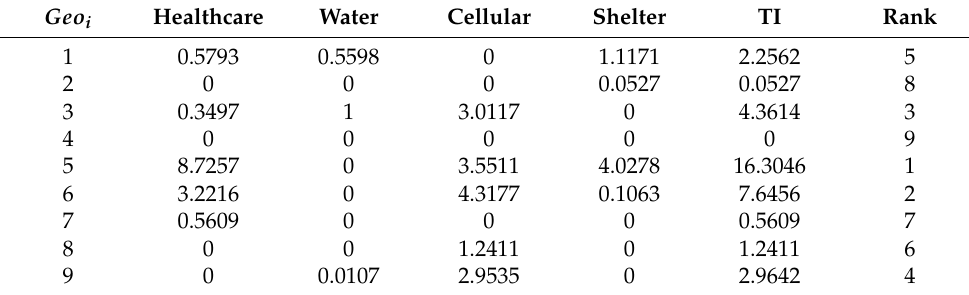
Table 8. Total importance value for every zone.